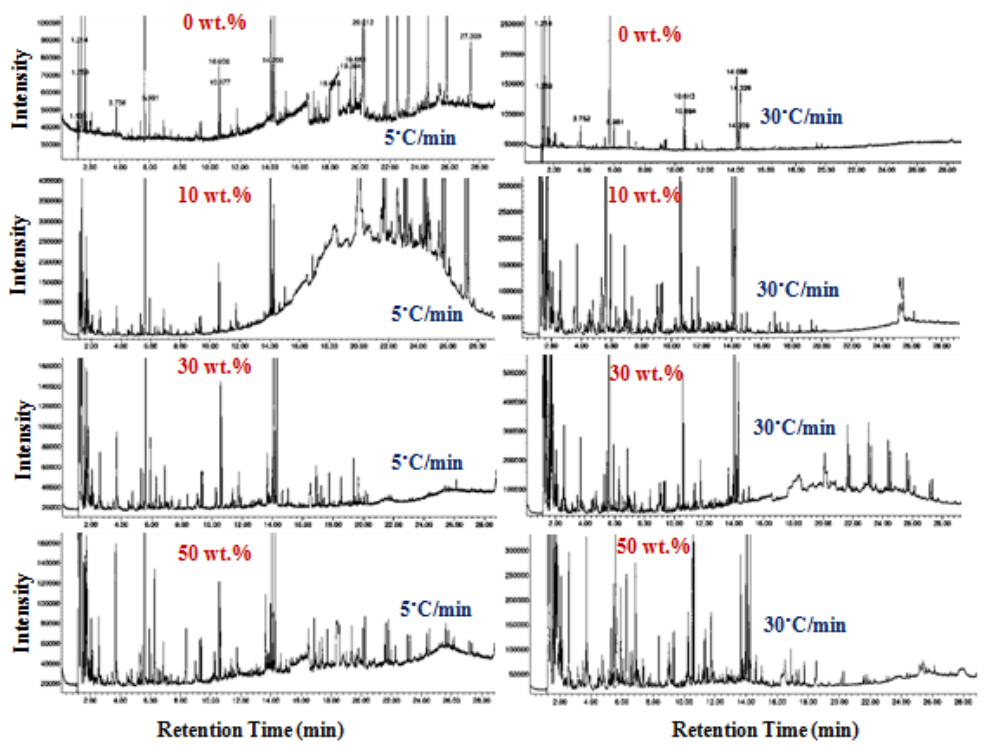
Figure 4. GC–MS analysis of the decomposed MFPW compounds at different loading of catalysts and different heating rates.